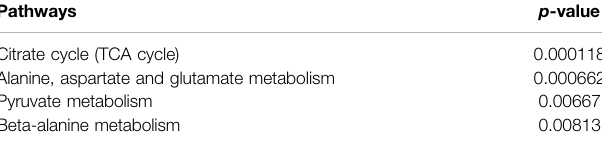
TABLE 3 | KEGG global metabolic network analysis of differential